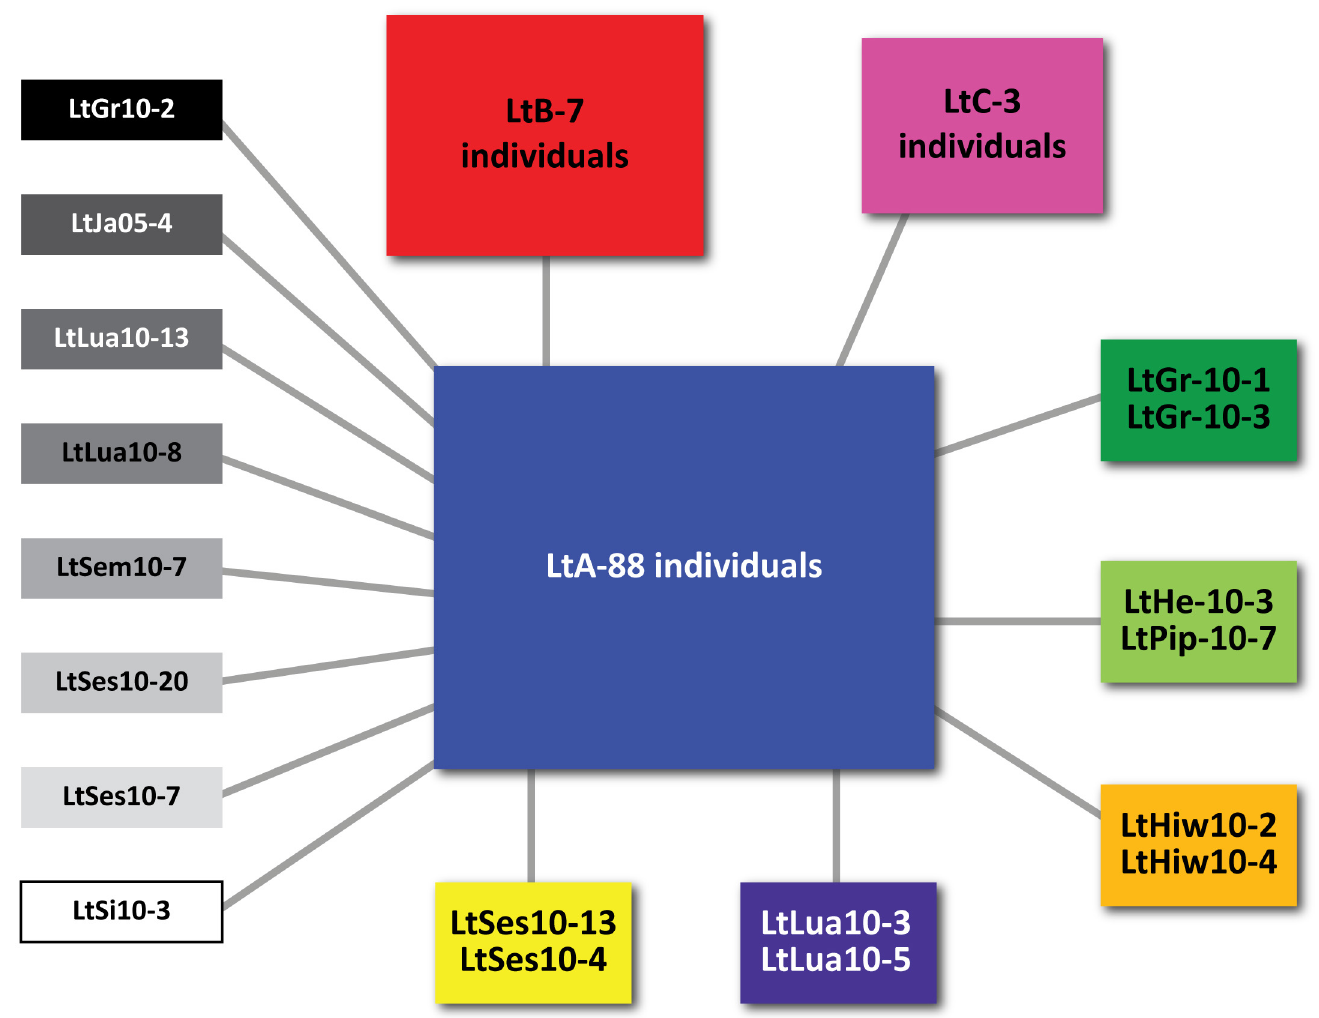
Fig 2. Minimum-spanning haplotype network for concatenated COI and CytB data from 116 Lednia tumana individuals. Individual haplotype colors correspond to those in Fig